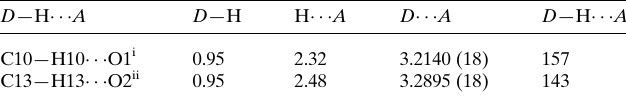
Table 1 Hydrogen-bond geometry (A˚ , (cid:4) ).